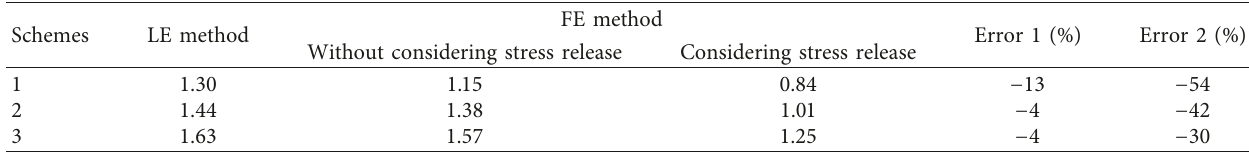
Figure 9: Influence of in situ stress release on stress distribution of the sliding surface: (a) normal stress distribution; (b) shear stress distribution. Note: represents the consideration of in situ stress release. Table 12: Influence of in situ stress release on safety factors and error